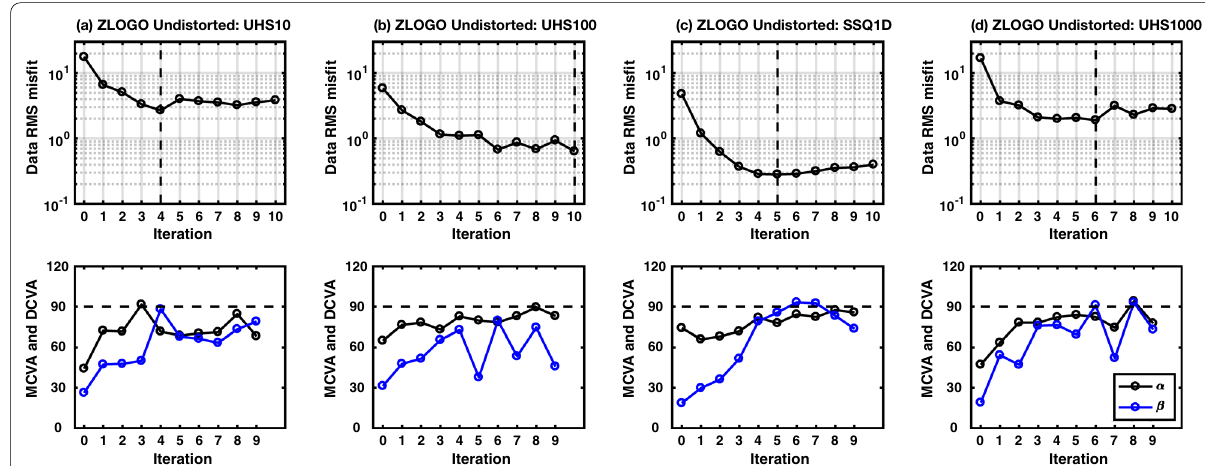
Fig. 16 dRMS (top, black solid curve with symbols) and the MCVA (bottom, black) and DCVA (bottom, blue) at each iteration step obtained from inverting ZLOGO of undistorted impedances using a UHS10, b UHS100, c SSQ1D, and d UHS1000 as the initial model. Dashed lines in the dRMS plots indicate the iteration step, where the dRMS is